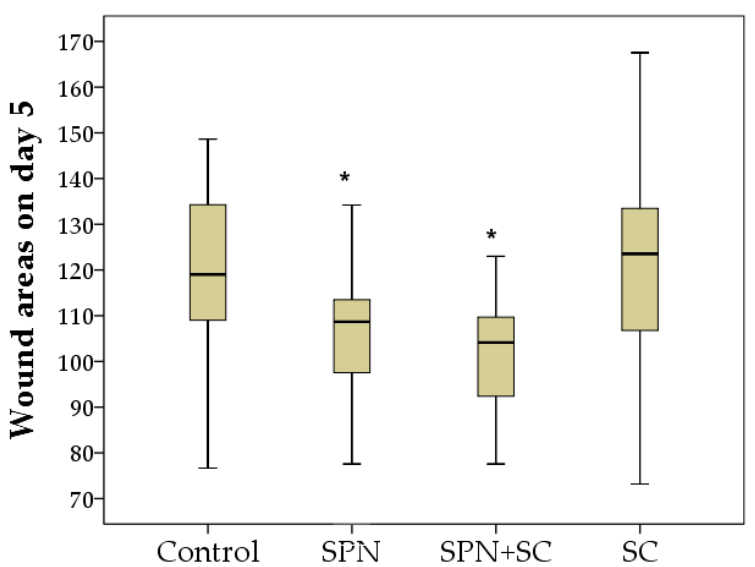
Figure 4. Wound areas on day 5 of the study in different groups (mm 2 ). Notes: *—difference from the control group at p < 0.05. Post hoc analysis score (Dunnett’s t -test for comparison with a control group). Data are presented as median and interquartile range.